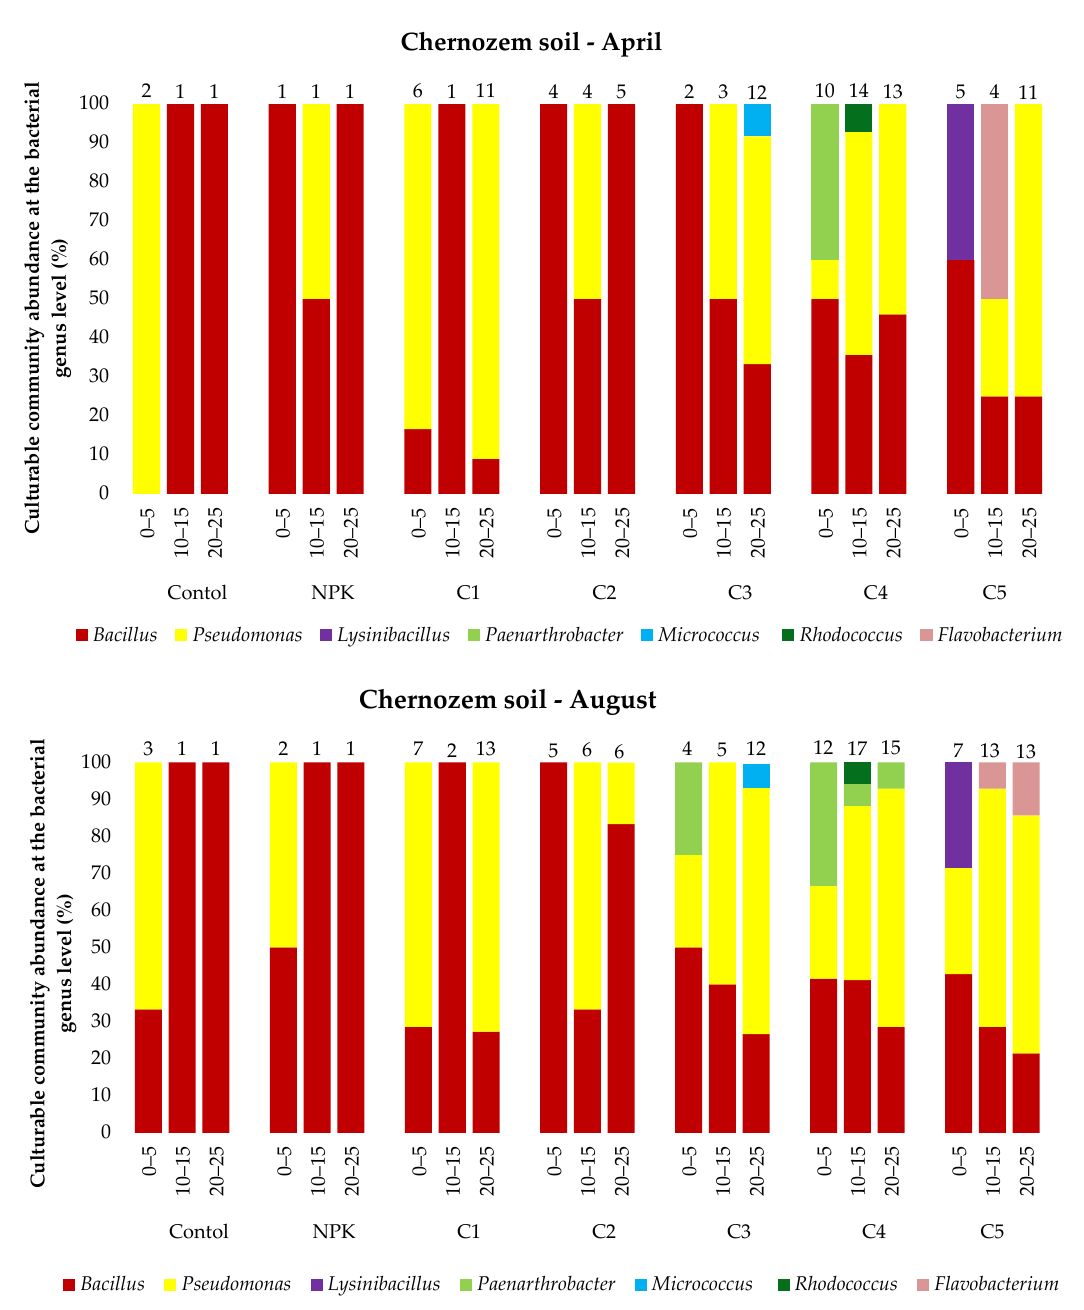
Figure 5. Culturable community abundance at the bacterial genus level (%) in the 0–25 cm layer of podzolic and chernozem soils in April and August 2021 after the application of different ash fertilizer doses; MALDI-TOF MS analysis . Numbers indicate the number of microorganisms identified.